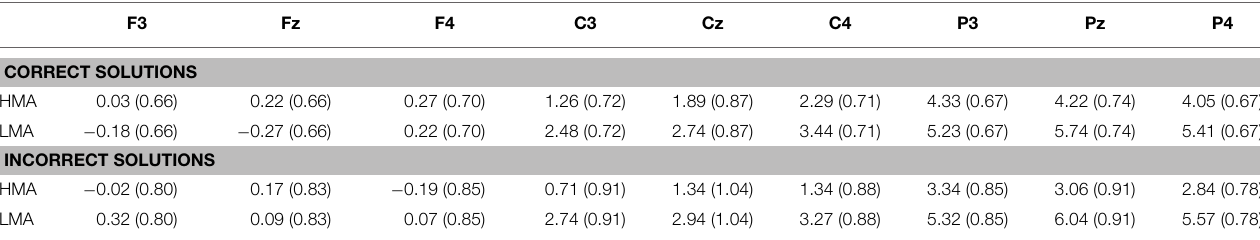
TABLE 4 | Mean amplitudes (in µ V) and standard error (in brackets) for the LPC component in the verification phase (400–600ms) for the HMA and LMA groups. F3 Fz